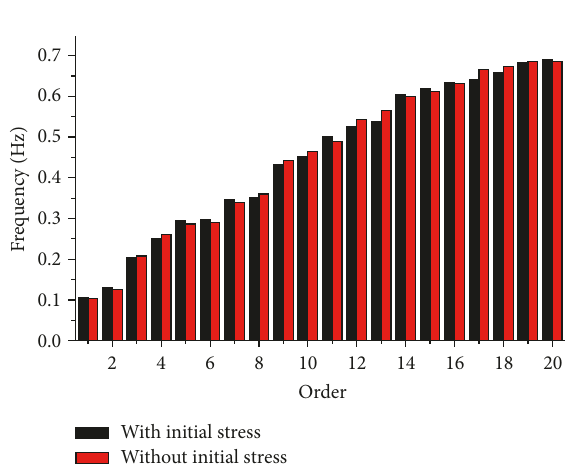
Figure 10: First 20-order frequencies of CFRP cable-stayed